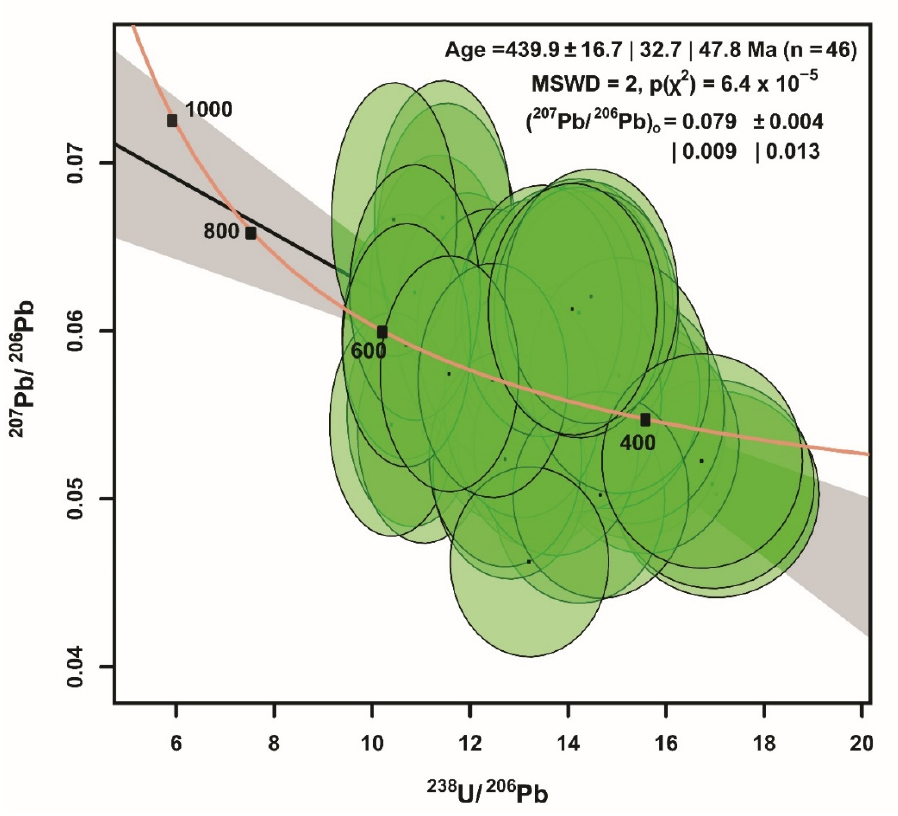
Figure 5. Tera–Wasserburg plots [86], displaying apatite U–Pb results obtained from the studied samples with excluding the discordant grains in Table 3.